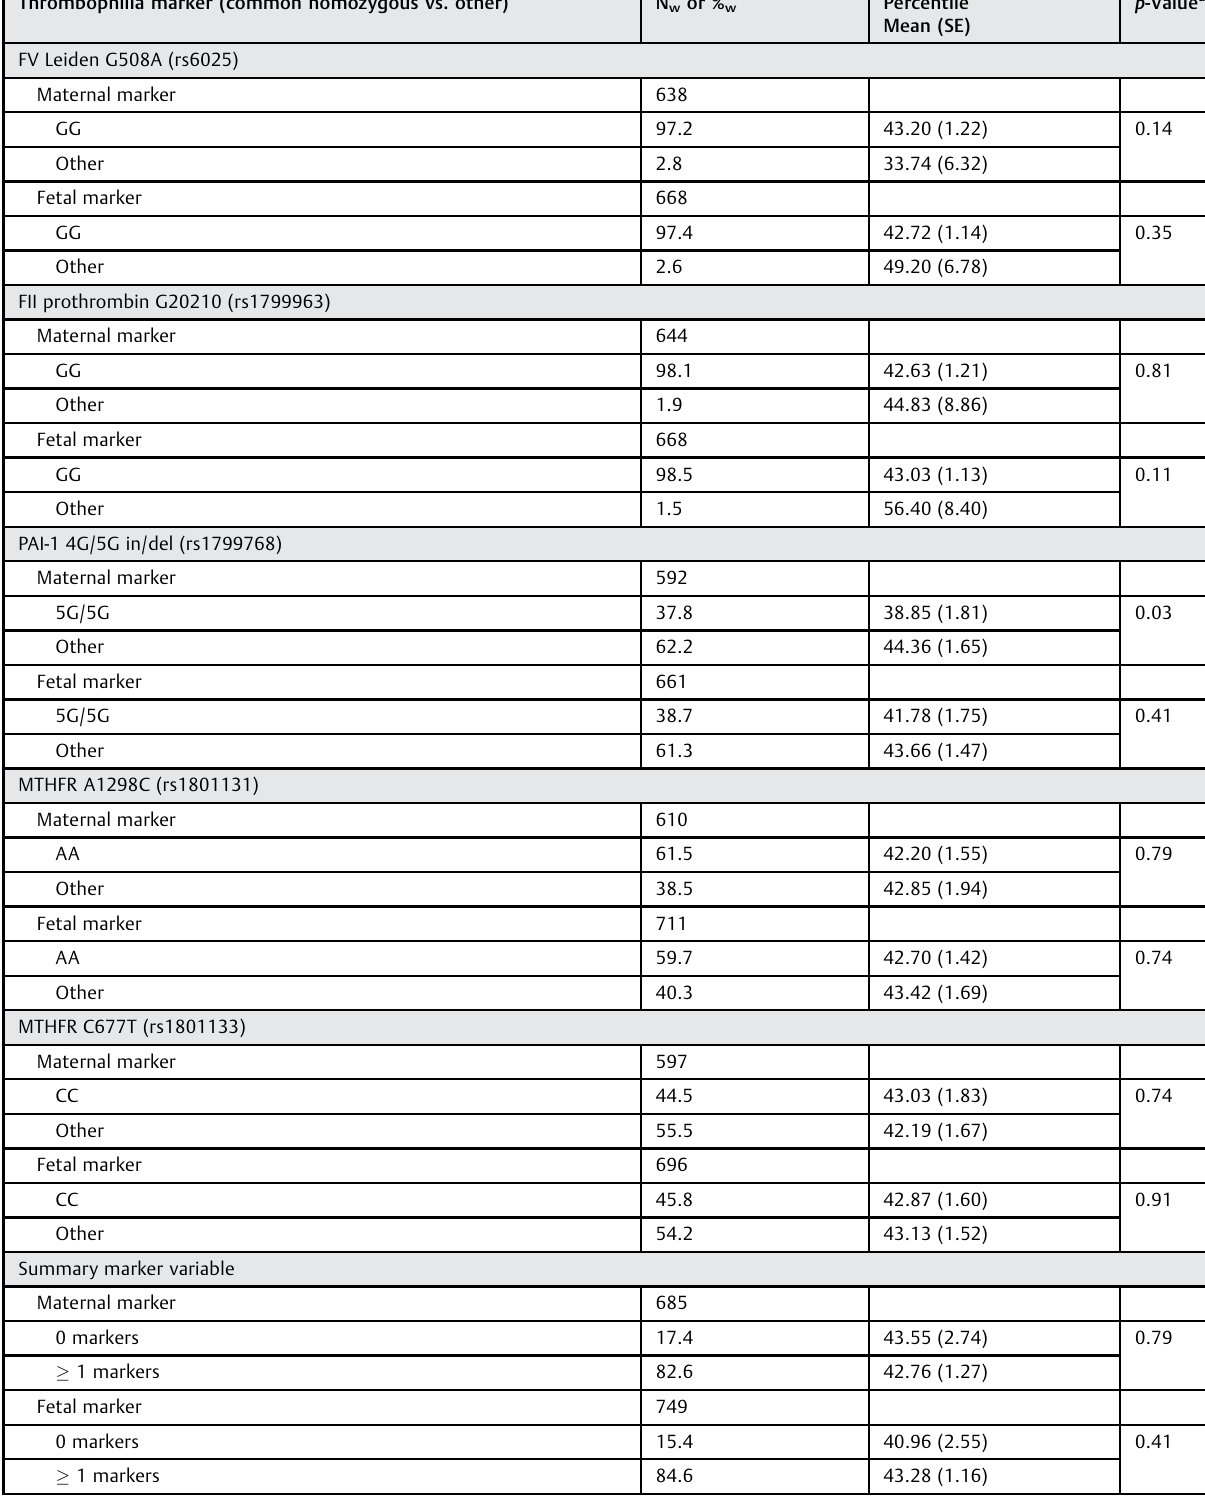
Table 2 Birth weight for gestational age percentile by presence of thrombophilia marker Thrombophilia marker (common homozygous vs.